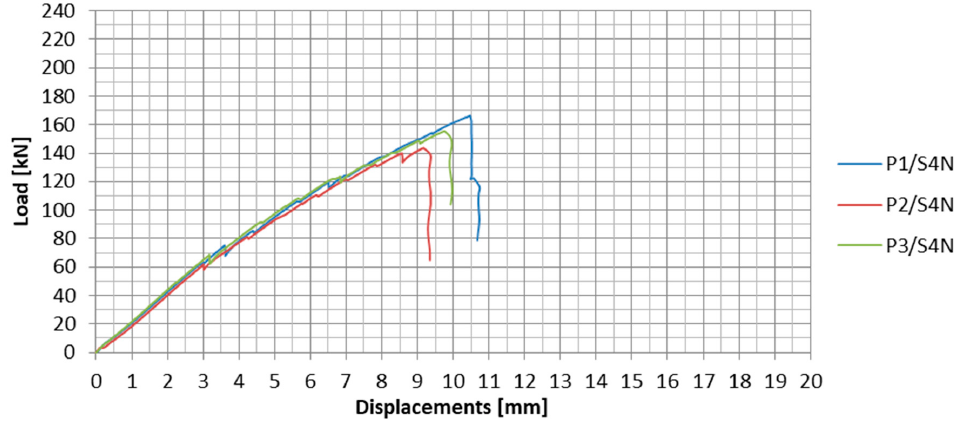
Figure 19. Load-displacement plots for all the specimens in the S4N series. Table 7. Test results of the specimens tested in S4N series.